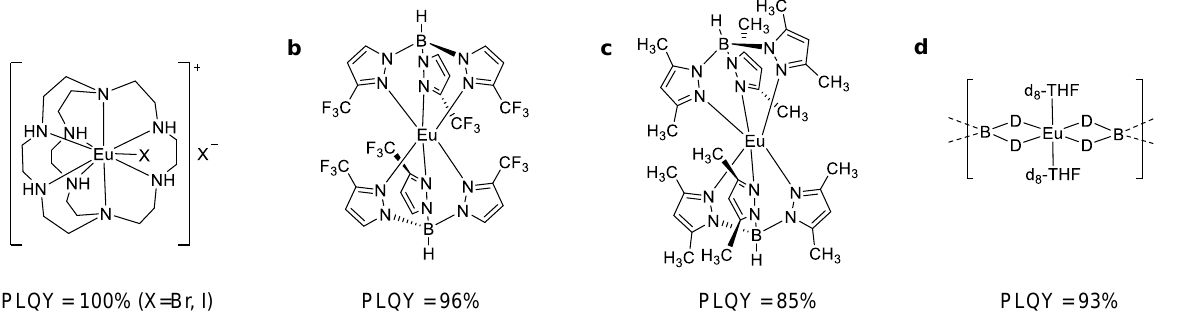
Figure 1. The previously reported Eu(II) complexes with high PLQYs.